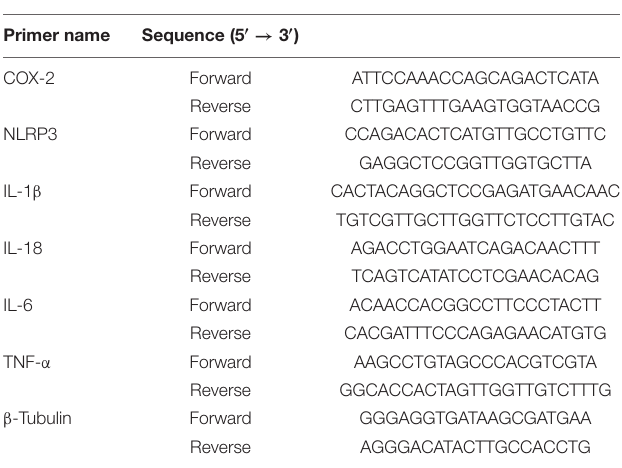
TABLE 2 | Primer sequences used in quantitative polymerase chain reaction in this